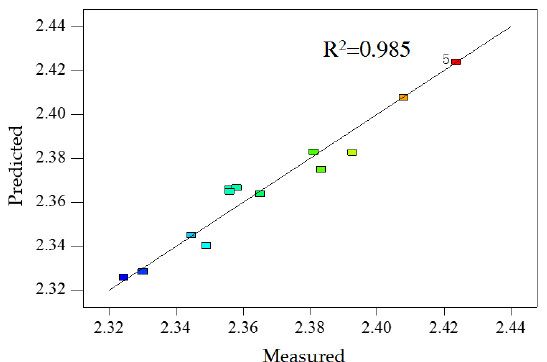
Figure 3. The measured and predicted values for density.